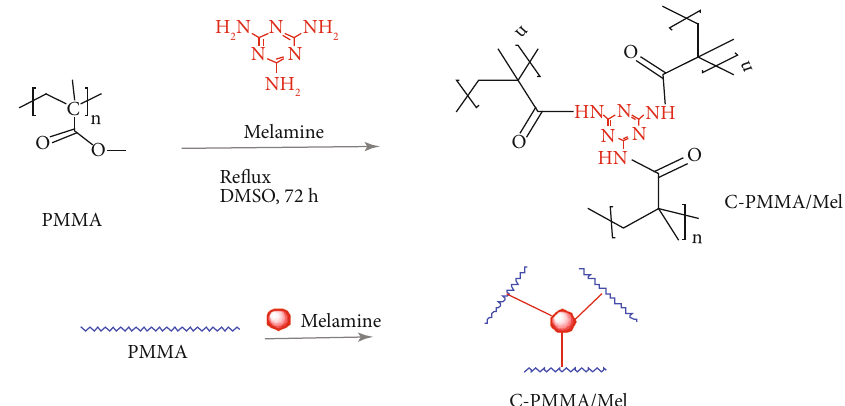
Figure 1: Synthetic routes to prepare C-PMMA/Mel.